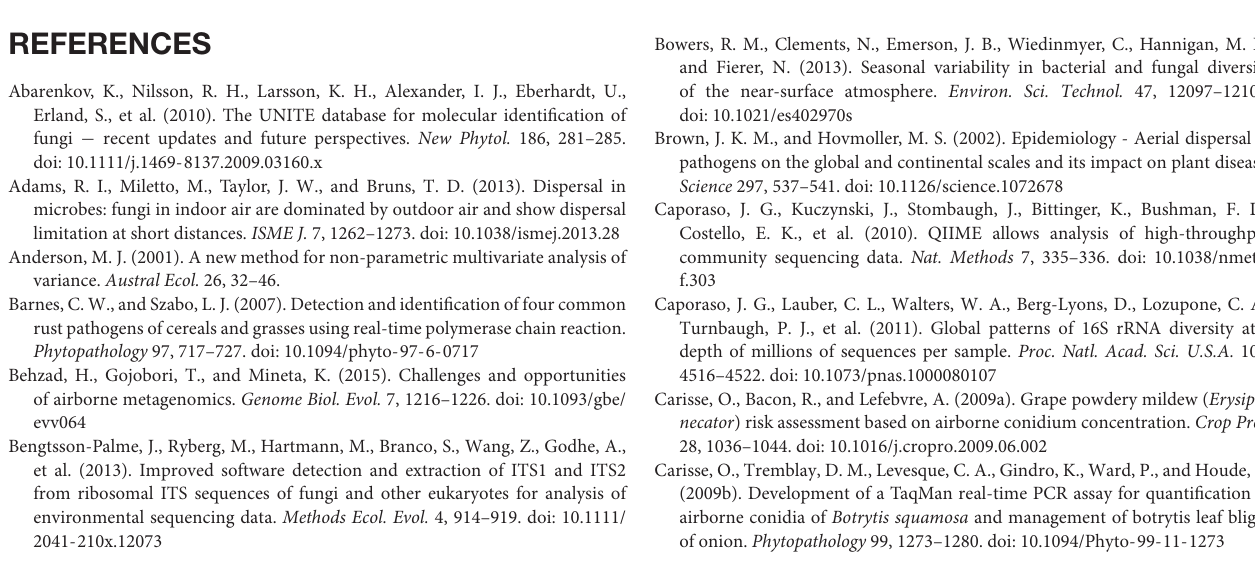
FIGURE S1 | Species accumulation curve showing the number of detected OTUs as a function of number of samples. TABLE S1 | Operational taxonomic unit (OTU) table including taxonomic classification, sequencing run, barcode used, location, date of sampling and